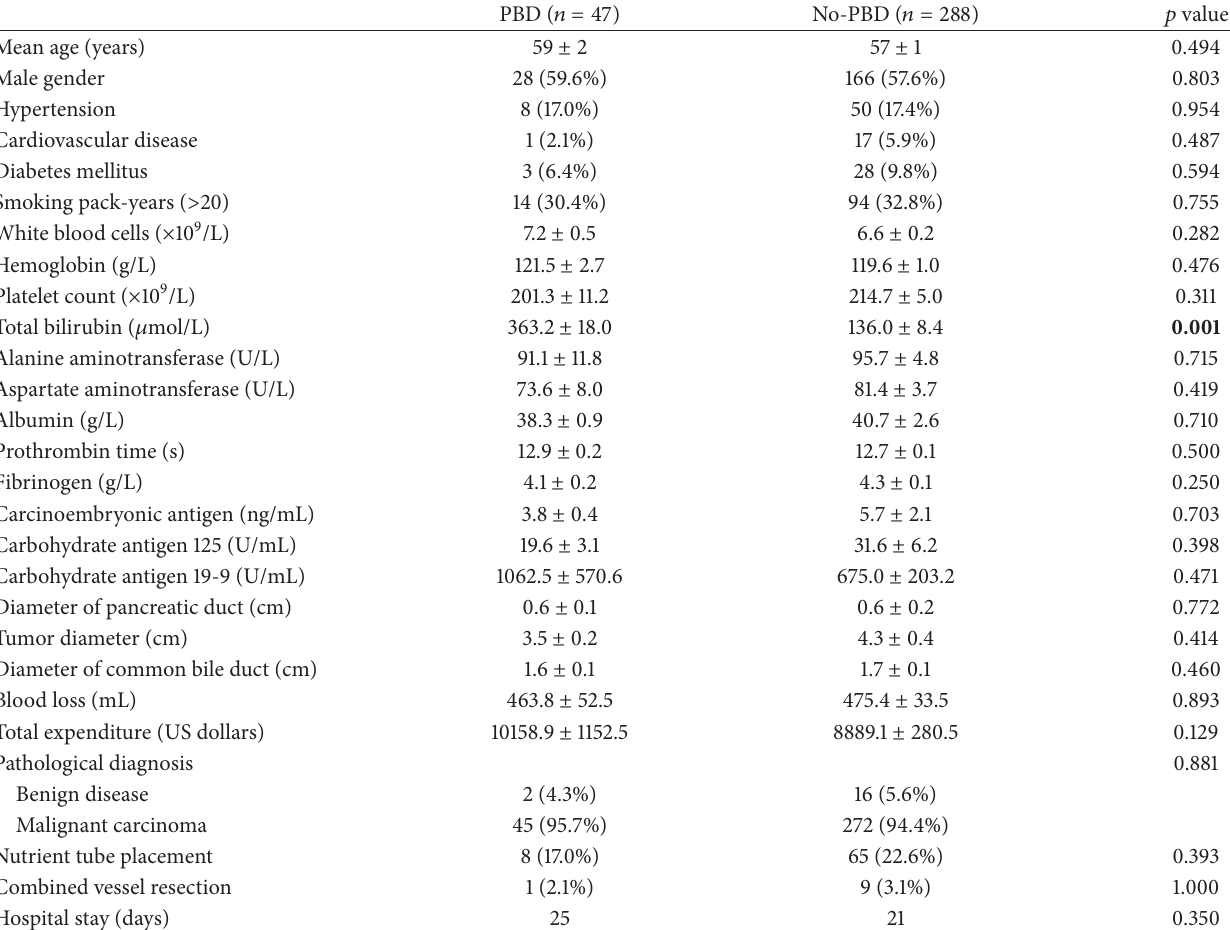
Table 1: Clinical baseline characters of the patients with and without preoperative